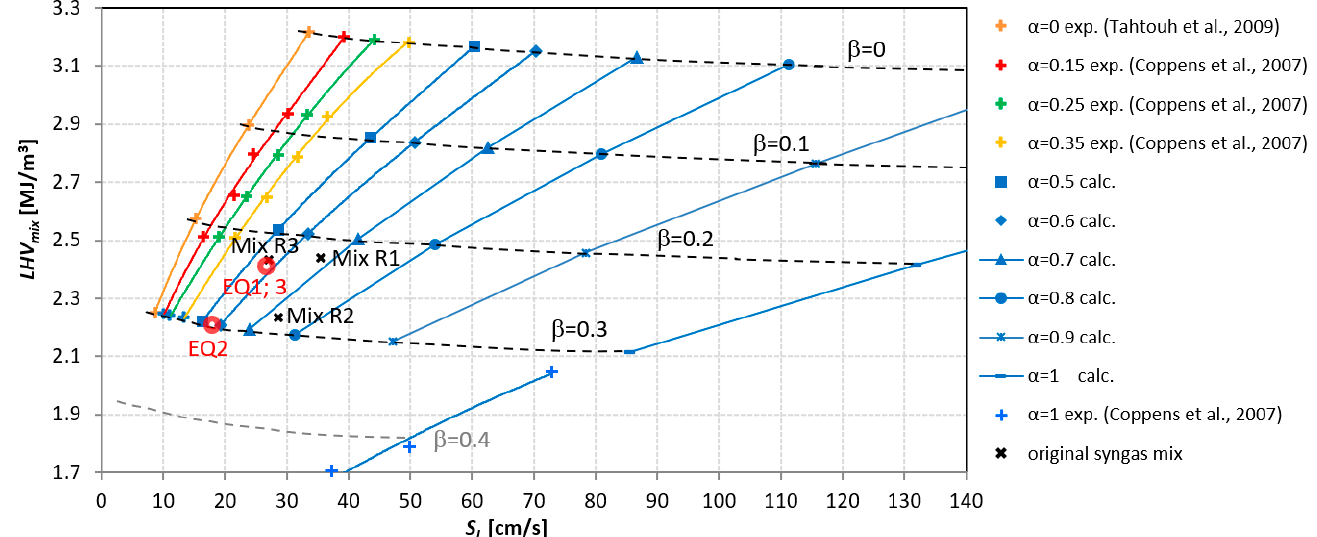
Figure 2. ( S L ; LHV mix ) surrogate map of the three-component H 2 –CH 4 –N 2 mixtures obtained via experimental data, and the GRI-Mech 3.0 and San Diego mechanisms. The map is an extended version of the one presented in [21] and includes the experimental data from Tahtouh et al. [22] and Coppens et al. [23].